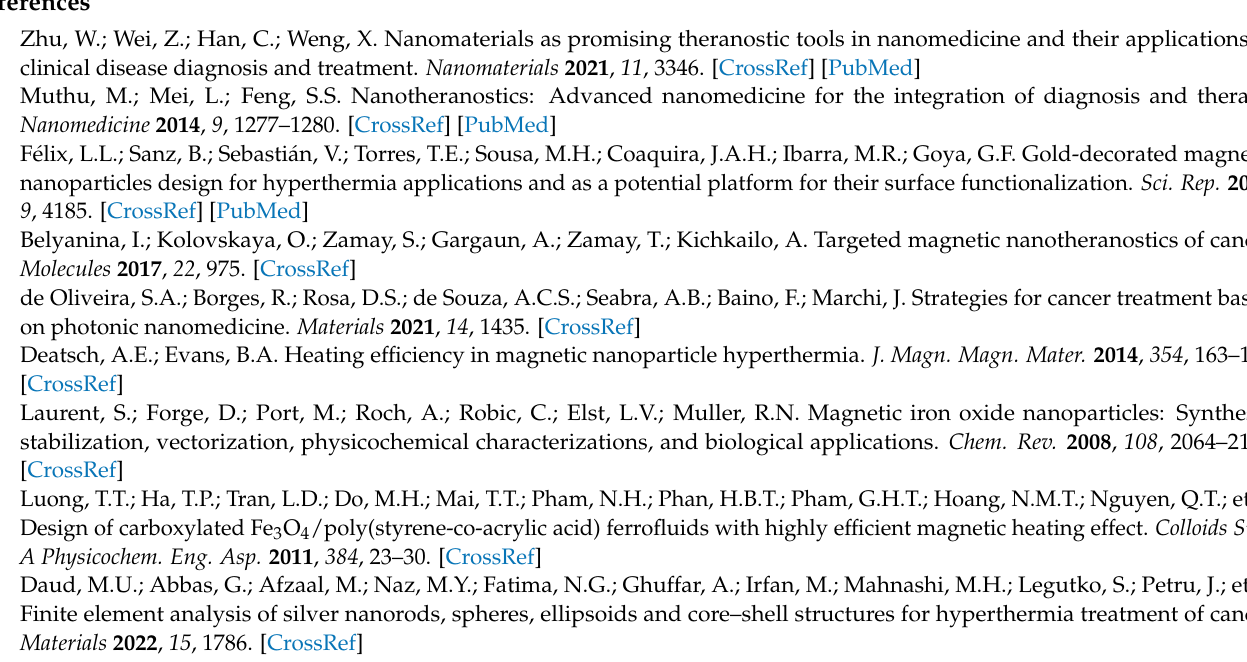
NC; Figure S2: The zeta potential distribution of FOA